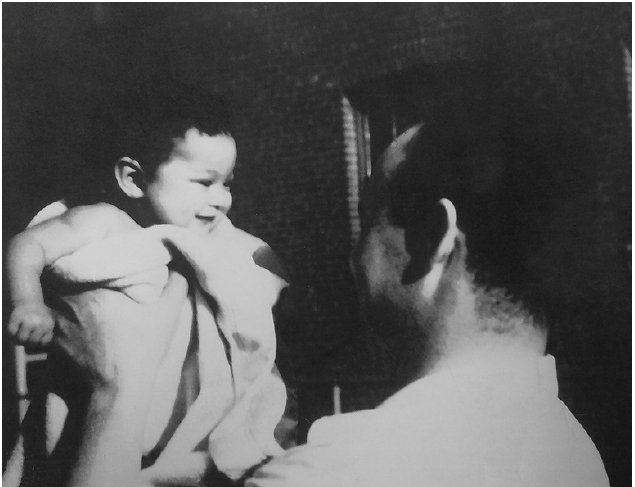
Figure 2 Sylvia Drew Ivie and Dr. Charles R. Drew in front of their apartment on Sherman Avenue, Washington DC,